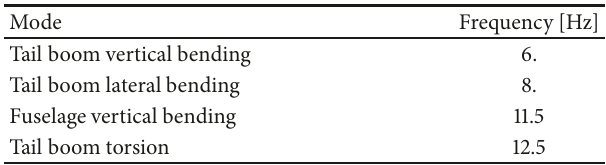
Table 5: Airframe